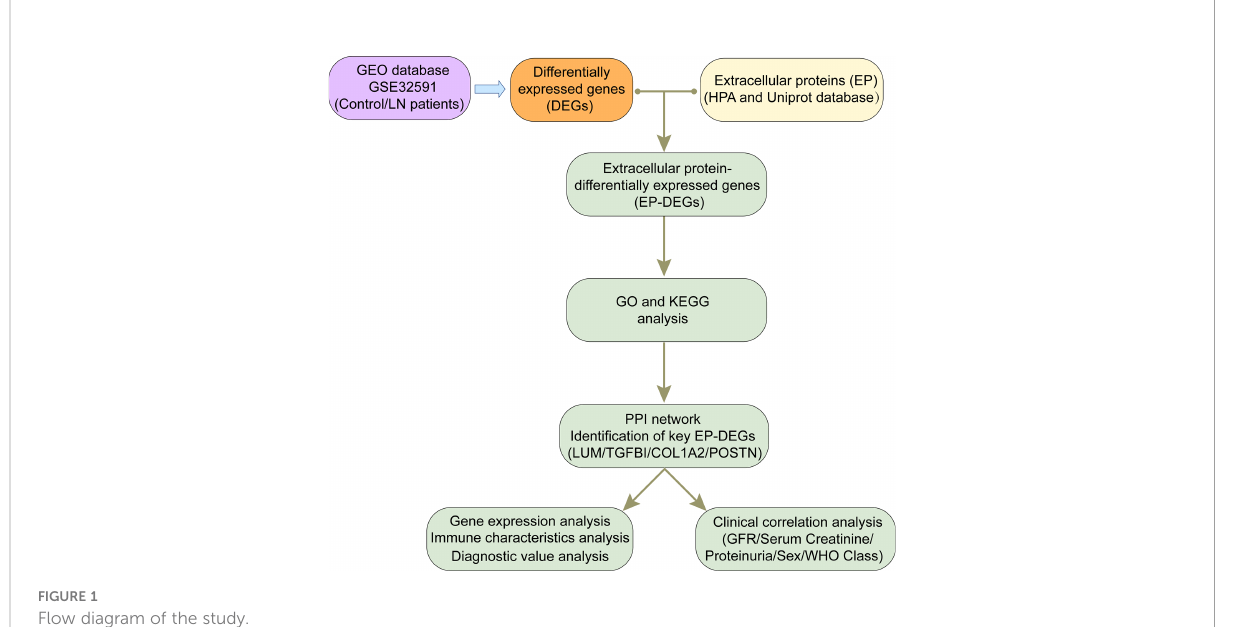
FIGURE 1 Flow diagram of the